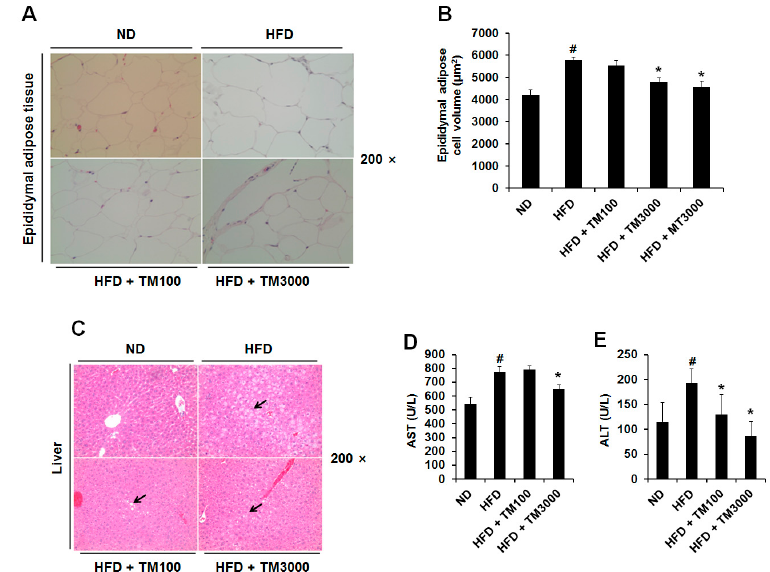
Figure 4. Effect of TML on histology of epididymal adipose and liver tissues of mice fed high-fat